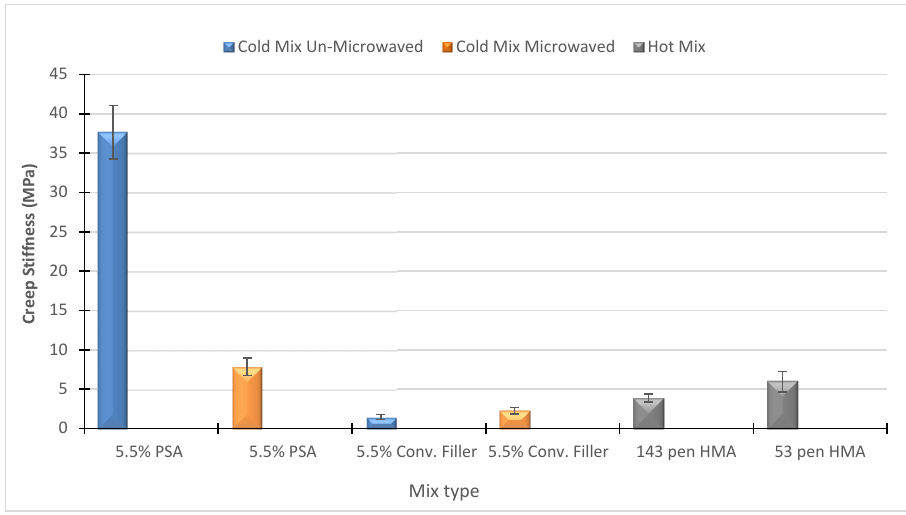
Figure 9. Effect of MW treatment on creep stiffness .